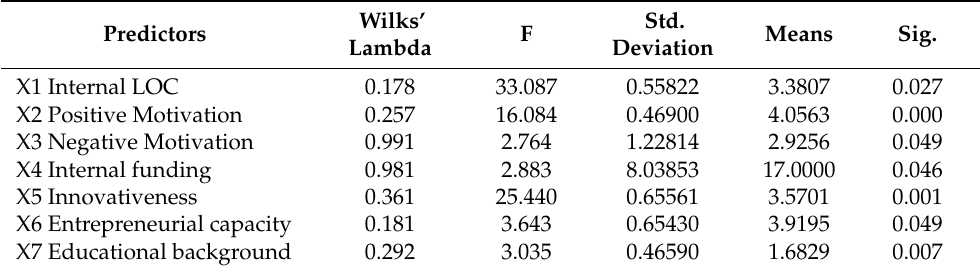
Table 5. Variables in the model (selected via stepwise procedures).